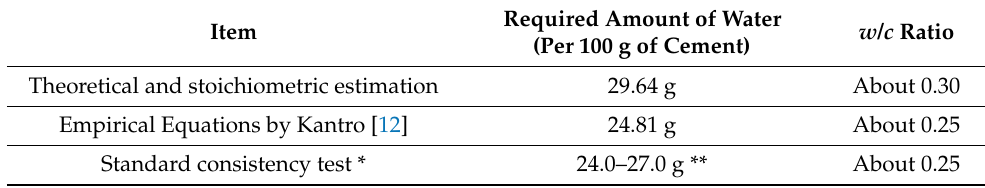
Table 5. Minimum w / c ratio required for hydration reactions of Portland Cement Type I.